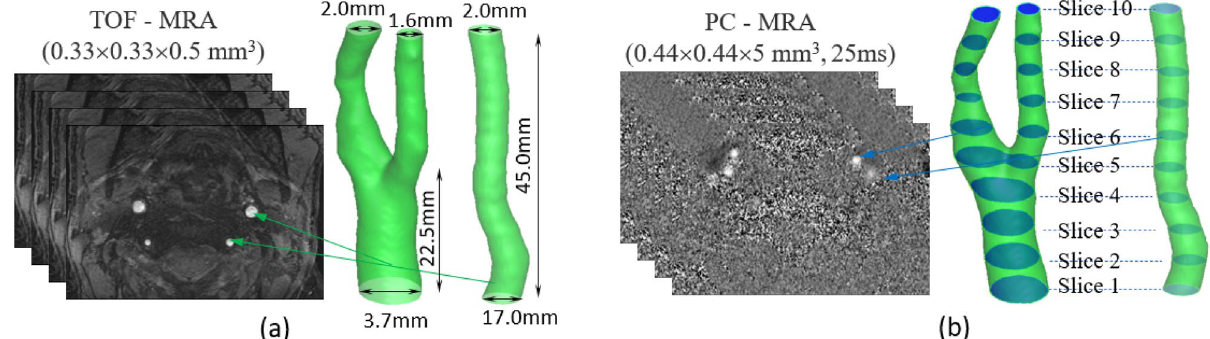
Figure 9. (a) High resolution 3-D TOF-MRA images and the segmented left carotid artery (with a bifurcation) and vertebral artery (tube-like). (b) 4-D Low resolution 4-D PC-MRA images with 10 locations along the arteries and 20 time points in one cardiac